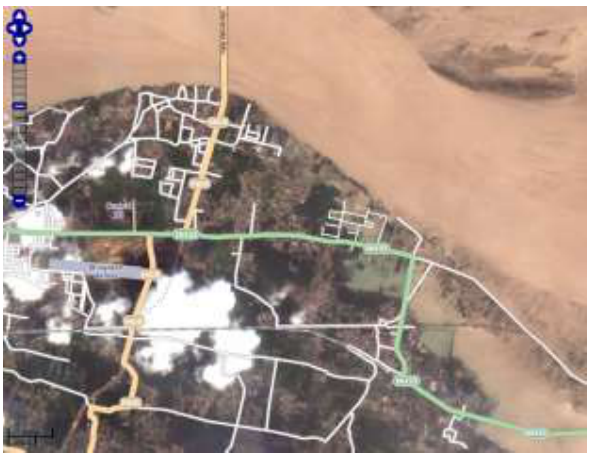
Figure 3. Tile-based visualization of flooded areas (flood event in India, 2016, data © OpenStreetMap-Contributors, USGS) The tile-based map presentation can be retrieved via stationary and mobile devices with internet